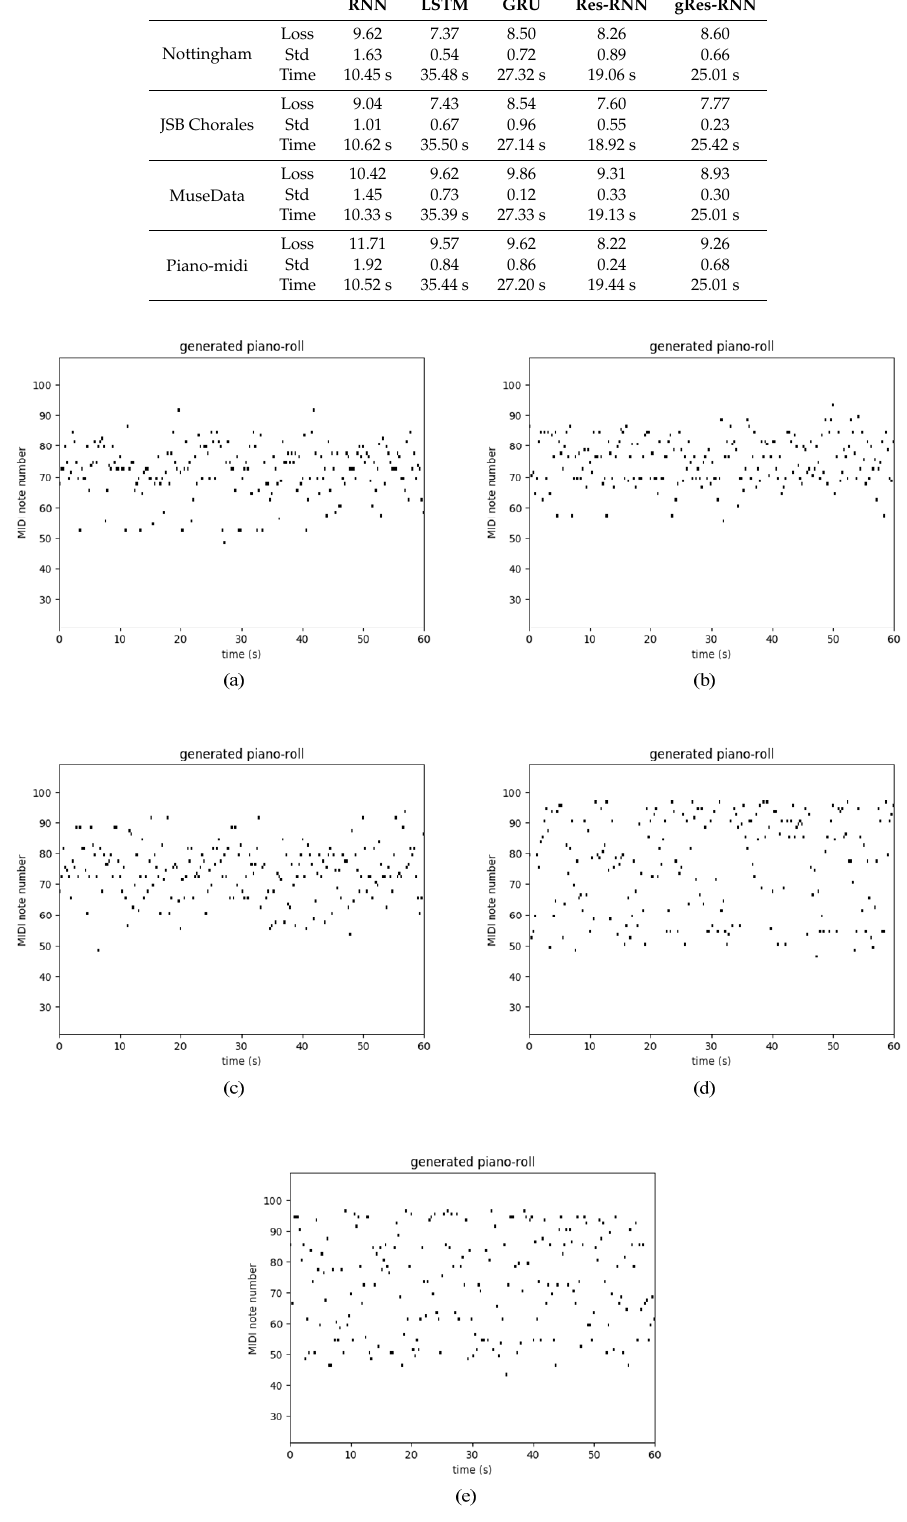
Figure 7. Sample of polyphonic music generation by the ( a ) RNN [9], ( b ) LSTM [16] and ( c ) GRU [17], ( d ) Res-RNN and ( e ) Res-RNN with gates trained with the databases of JSB Chorales.